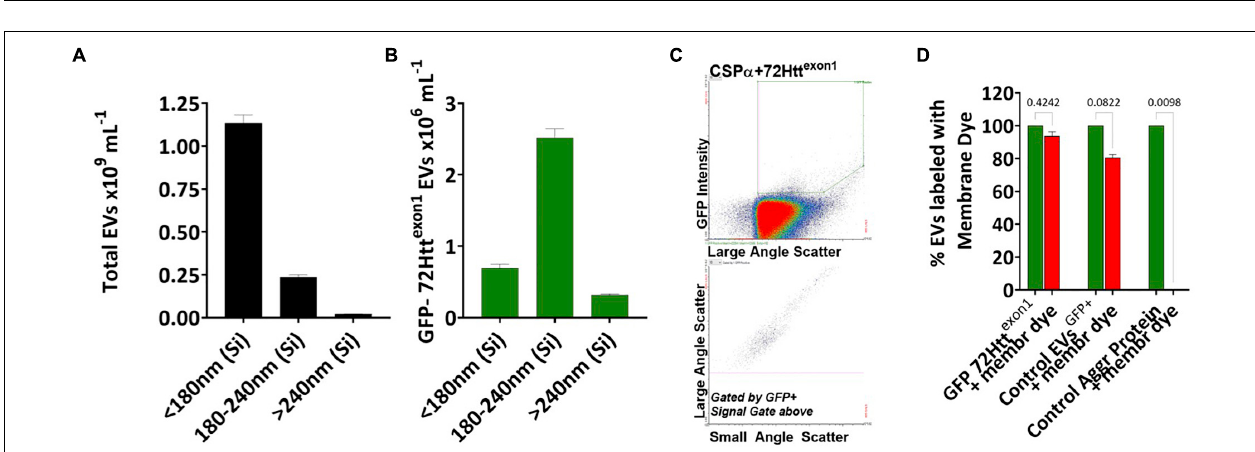
FIGURE 1 | Microflow cytometry showing the influence of CSP α on EV export (A) experimental approach, EVs were examined without enrichment. (B) Bar graph of the concentration of total EVs released and (C) bar graph of the GFP-72Htt exon1 -containing EVs released as determined by microflow cytometry (**** P < 0.0001).